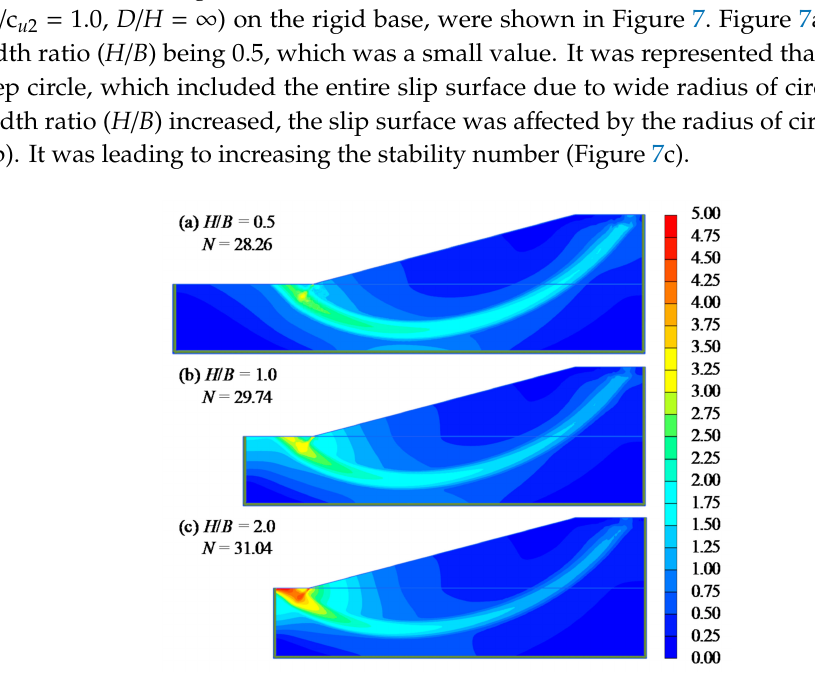
Figure 7. Total deviatoric strain according to width ratio ( H / B ), where T / H = 2, c u 1 / c u 2 = 1.0, D / H = ∞ , β = 15 ◦ ( a ) H / B = 0.5, ( b ) H / B = 1.0, and ( c ) H / B =